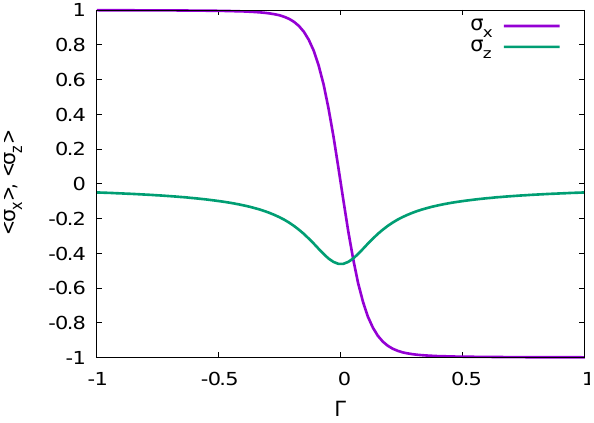
Figure 1: Magnetization along the x and the z axis for β = 10, h = 0.05 and variable Γ